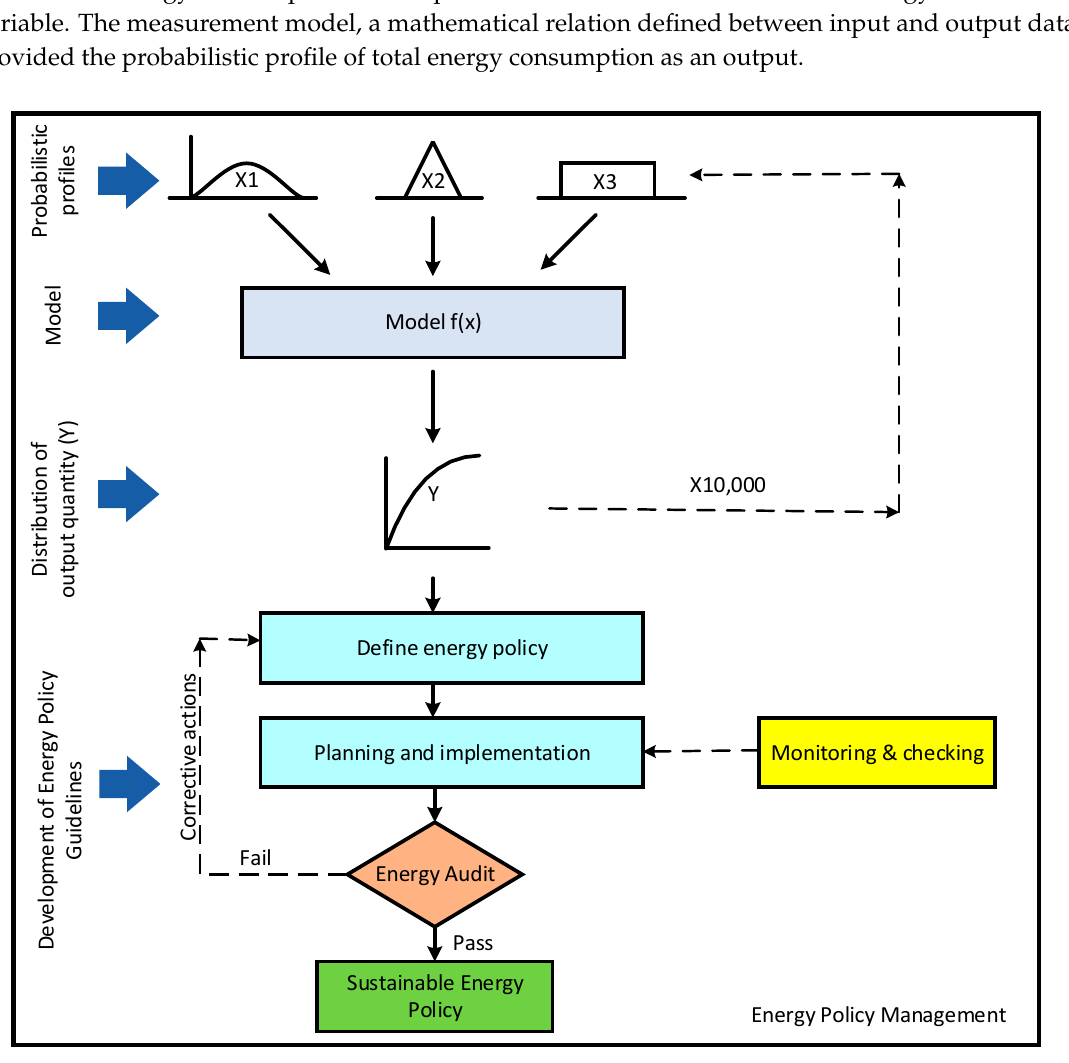
Figure 2. Methodology for development of energy policy guidelines.